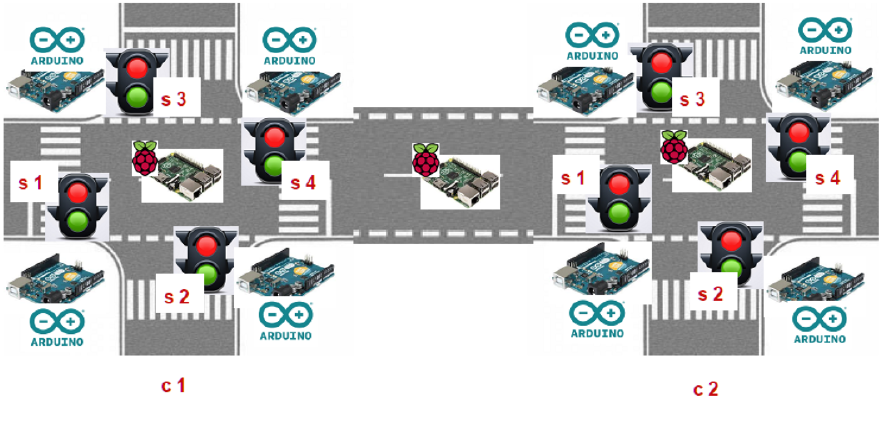
Figure 5. A Smart City use case: crossroads with traffic